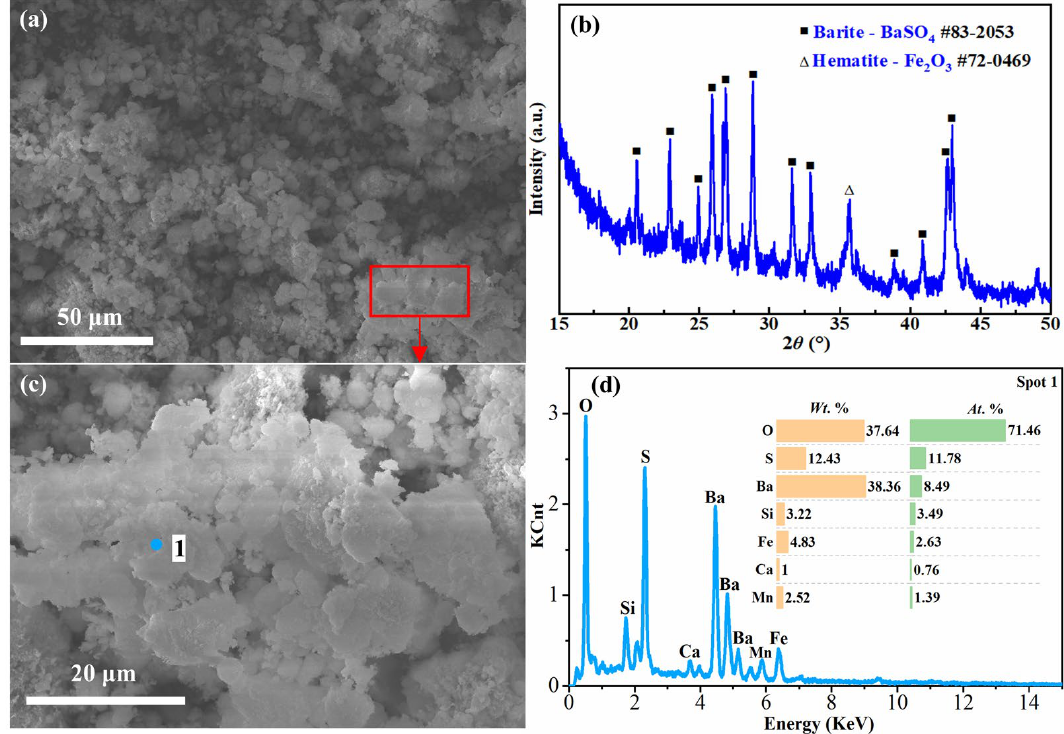
Figure 11. SEM image with EDS analysis and XRD pattern of acid leaching residue of 6 mol/L H 2 SO 4 at 2 min: ( a ) SEM image and ( b ) XRD pattern of the acid leaching residue of 6 mol/L H 2 SO 4 at 2 min; ( c ) enlarged image of the frame area in Figure 11a; ( d ) EDS analysis of Spot 1 in Figure 11c.